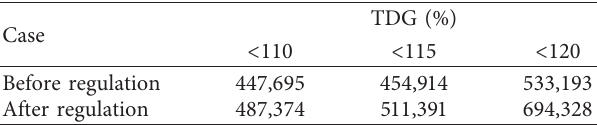
Table 2: Area statistics of different TDG levels before and after the waterway